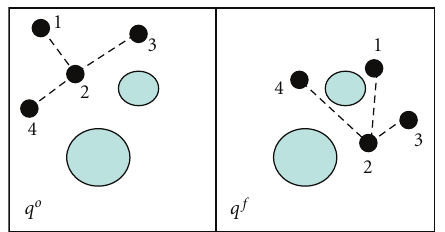
Figure 1: The basic problem considered in this paper. Design a control law to guide the swarm from the initial position, q o , to the desired final position, q f , while maintaining desired com- munication links (range plus line of sight).